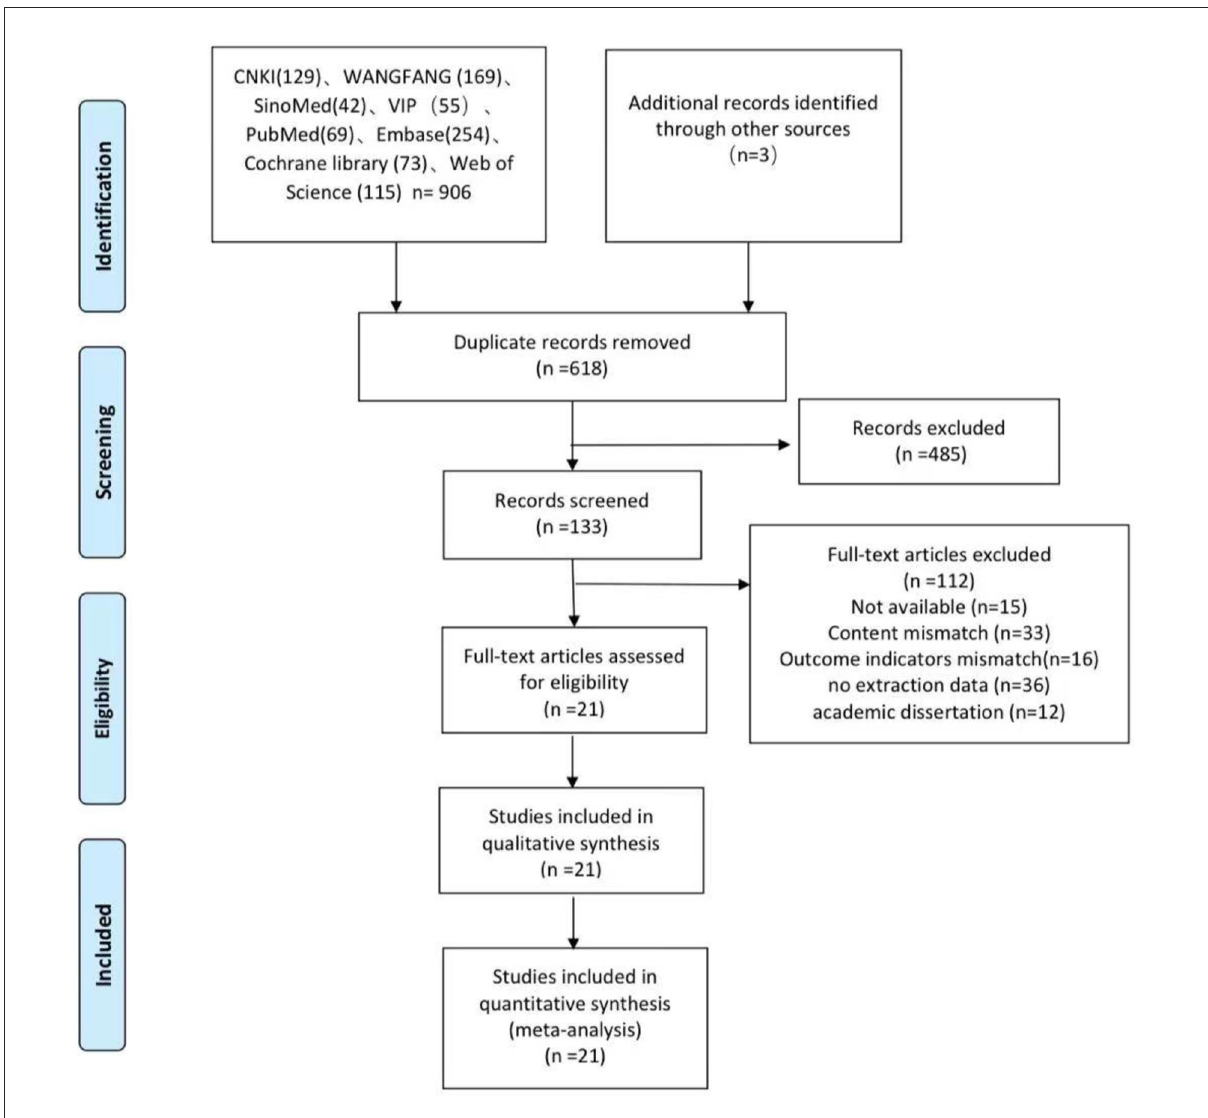
FIGURE1 Flowchart of the study search and selection